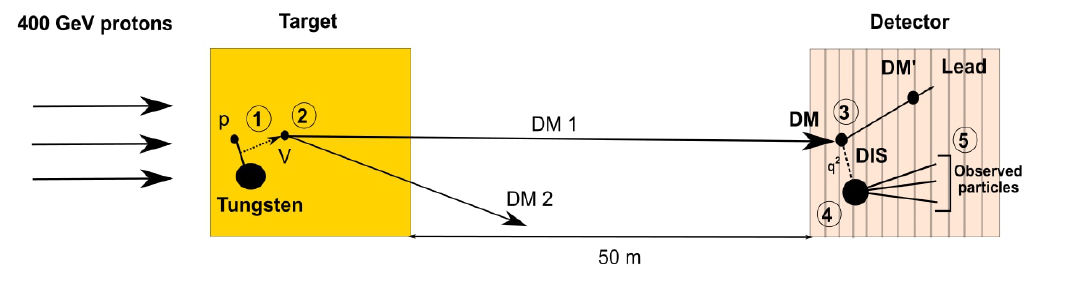
Figure 5. Simulation scheme.